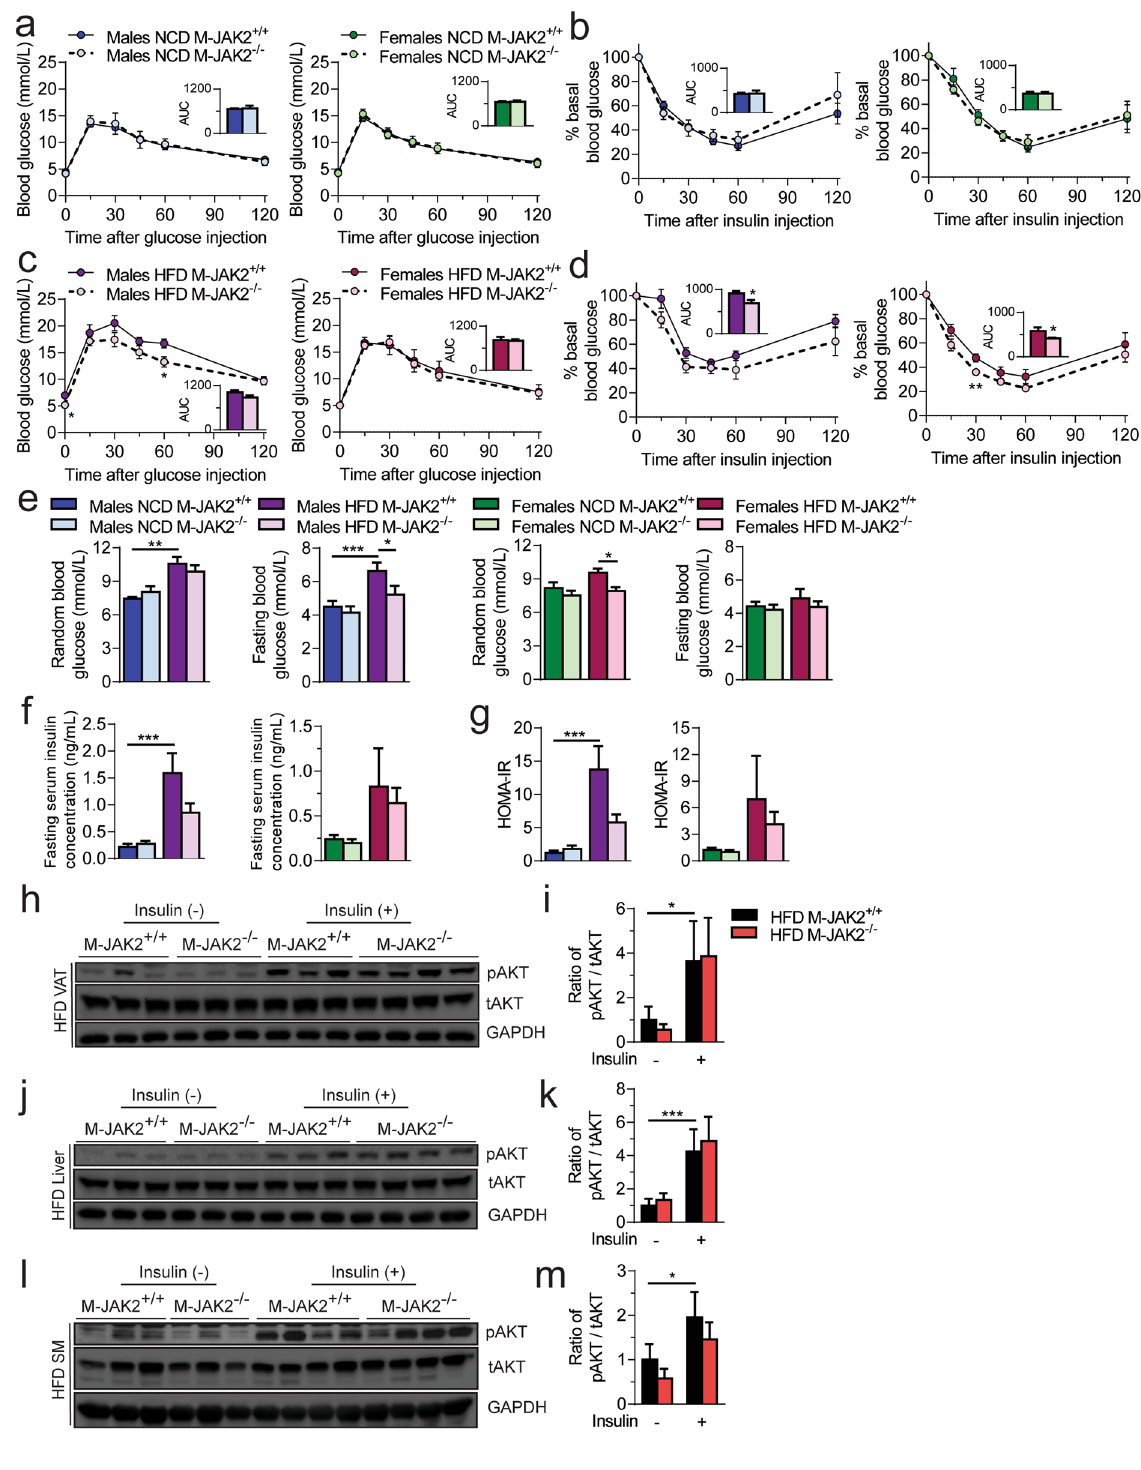
Figure 3. Increased systemic insulin sensitivity in HFD fed M-JAK2 − / − mice. Male and female M-JAK2 + / + and M-JAK2 − / − mice subjected to glucose tolerance test during ( a ) NCD feeding (n = 5–8 males, n = 9 females) or ( b ) HFD feeding (n = 9–10 males, n = 11–13 females) feeding. Male and female M-JAK2 + / + and M-JAK2 − / − mice subjected to insulin tolerance test during ( c ) NCD feeding (n = 5–8 males, n = 8 females) or ( d ) HFD feeding (n = 7–9 males, n = 9–12 females) feeding. Area under the curve (AUC) was measured using baseline glucose values. ( e ) Random and fasting blood glucose levels measured in male and female M-JAK2 + / + and M-JAK2 − / − mice during NCD feeding (n = 5–8 males, n = 9 females) or HFD feeding (n = 9–10 males, n = 9–12 females). ( f ) Fasting serum insulin levels and ( g ) homeostasis model assessment of insulin resistance (HOMA-IR) calculated in male and female M-JAK2 + / + and M-JAK2 − / − mice fed NCD (n = 6–7 males, n =